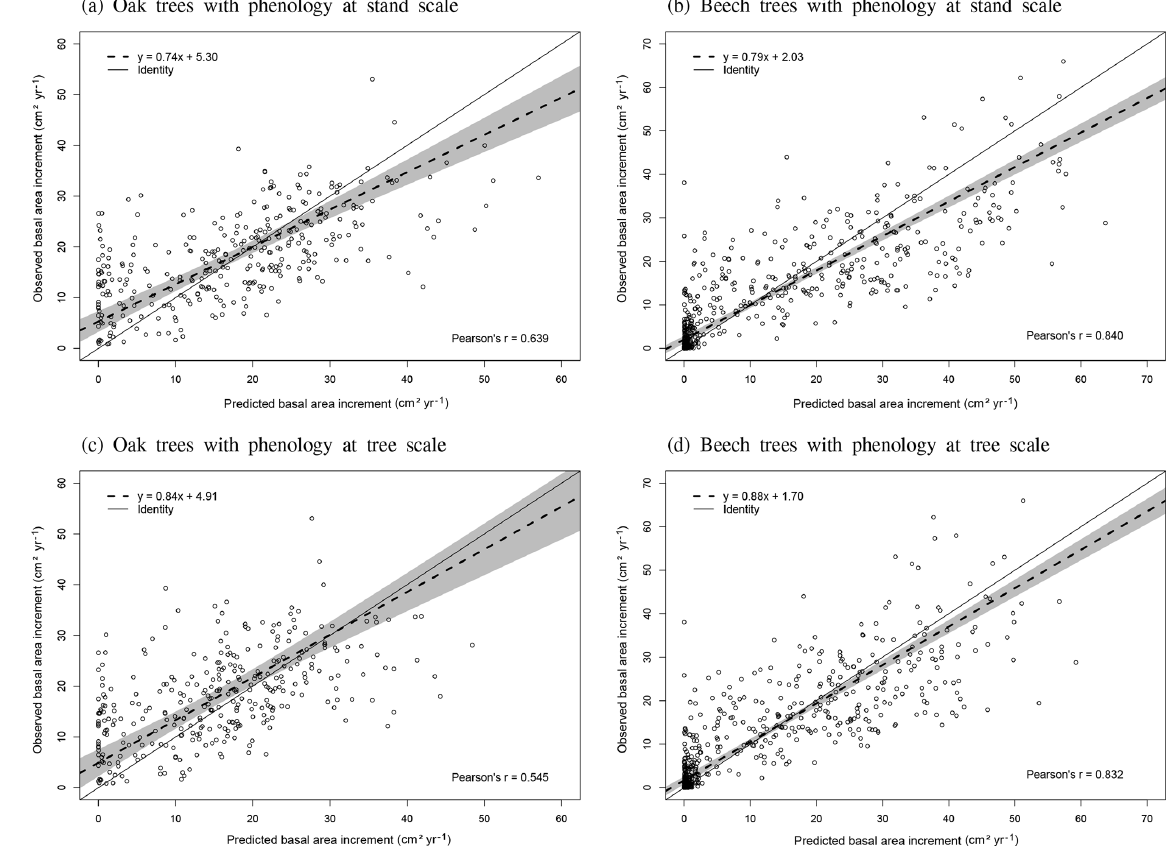
Figure D1. Comparison of observed and predicted basal area increments for sessile oak and European beech considering the two phenology modalities (tree vs. stand scale). The quality of predictions is indicated by the Pearson’s correlation coefficient ( r ). The shaded area represents the confidence interval of the Deming regression (95%) of observations on predictions, and the solid line corresponds to the identity